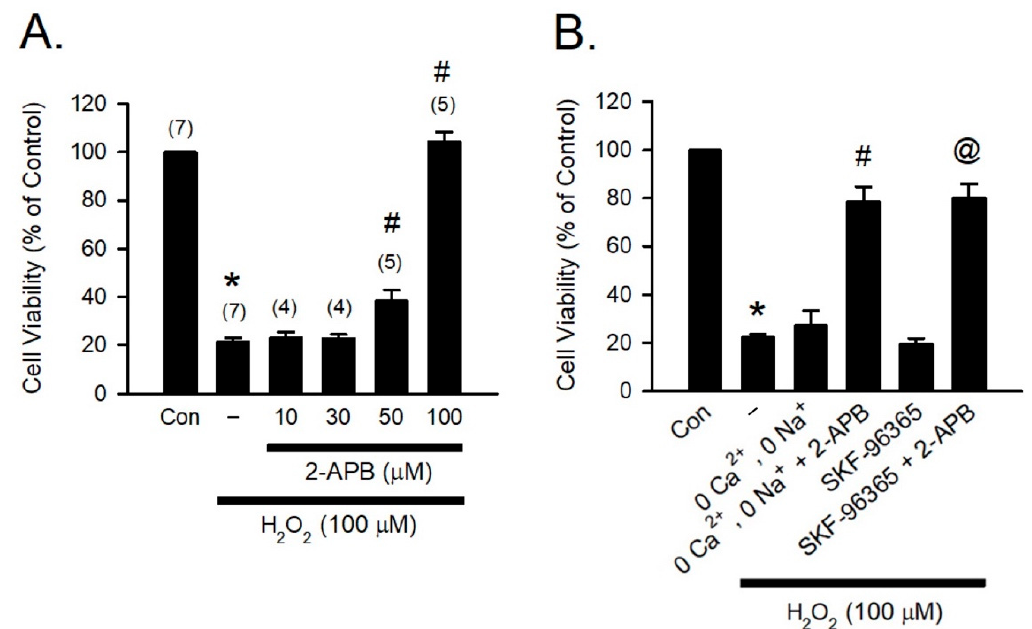
Figure 1. 2 ‐ APB protects the H 2 O 2 ‐ induced H9c2 cell death. ( A ) 2 ‐ APB at concentrations of 50 and 100 μ M significantly attenuated the H 2 O 2 ‐ induced cell death. Values shown in parenthesis represent the number in each group. * p < 0.05 different from control; # p < 0.05 different from H 2 O 2 . ( B ) Treatment with a transient receptor potential canonical (TRPC) channel blocker ‐ SKF ‐ 96365 (10 μ M) or incubation in the Ca 2+ and Na + free medium could not protect the H 2 O 2 ‐ induced cell death. However, treatment 4 h with 2 ‐ APB and SKF ‐ 96365 together or 2 ‐ APB in the Ca 2+ and Na + free medium significantly reduced the H 2 O 2 ‐ induced cell death. ( n = 5). * p < 0.05 different from control; # p < 0.05 different from the 0 Ca 2+ , 0 Na + + H 2 O 2 group; @ p < 0.05 different from the SKF ‐ 96365 + H 2 O 2 group. Data are expressed as mean ± SEM. Abbreviations: Con, control; SKF ‐ 96365, 1{ β‐ [3 ‐ (4 ‐ methoxyphenyl)propoxyl] ‐ 4 ‐ methoxyphenethyl} ‐ 1H ‐ imidazole hydrochloride; 2 ‐ APB, 2 ‐ aminoethoxydiphenyl borate; − , only H 2 O 2 (100 μ M) .